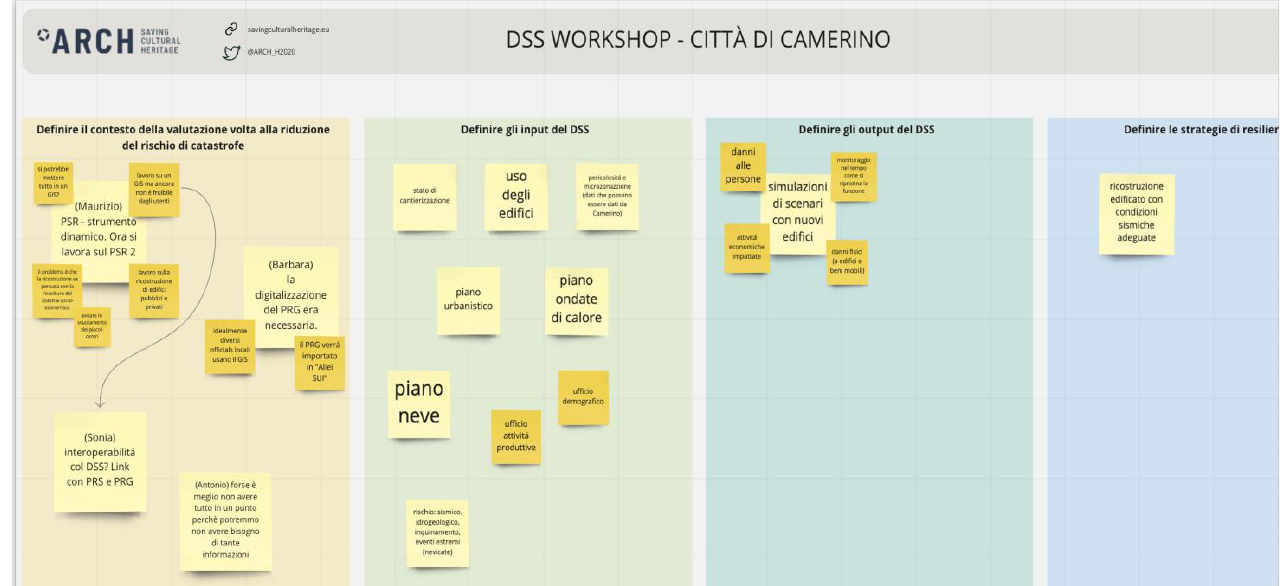
Figure 5. On-line interactive board used to support co-creation related to the ARCH DSS Camerino activities in particular during Workshops W2 and W3.